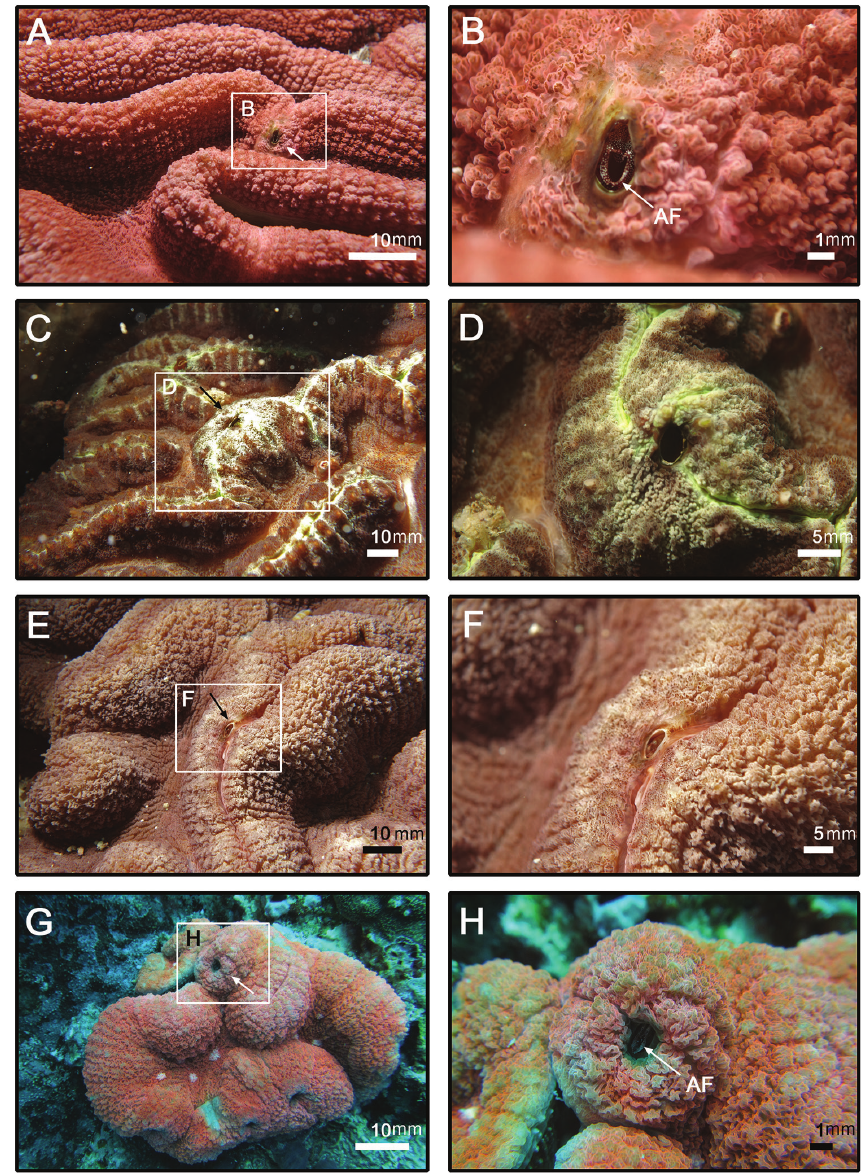
Figure 2. In-situ underwater photo of Galkinius maculosus sp. n. A Additional specimen CEL-DSA-117 (white arrow), on coral Lobophyllia sp., NE of Dongsha Atoll, Taiwan B Magnified photo of the barnacle (CEL-DSA-117) showing the spotted aperture frill C Additional specimen CEL-DSA-075 (white ar- row), on coral Lobophyllia sp., SE of Dongsha Atoll, Taiwan D Magnified photo of the barnacle (CEL- DSA-075) E Additional specimen CEL-DSA-097 (white arrow), on coral Lobophyllia sp., NE of Dongsha Atoll, Taiwan F Magnified photo of the barnacle (CEL-DSA-097) G Additional specimen CEL-DSA-201 (white arrow), on coral Lobophyllia sp., Northeast of Dongsha Atoll, Taiwan H Magnified photo of the barnacle (CEL-DSA-201) showing spotted aperture frill. (AF: aperture